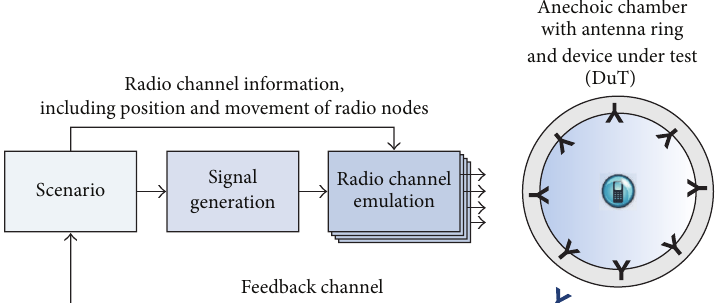
Figure 3: A typical implementation of an OTA in VEE test setup for the single-user downlink scenario for mobile communication UE.